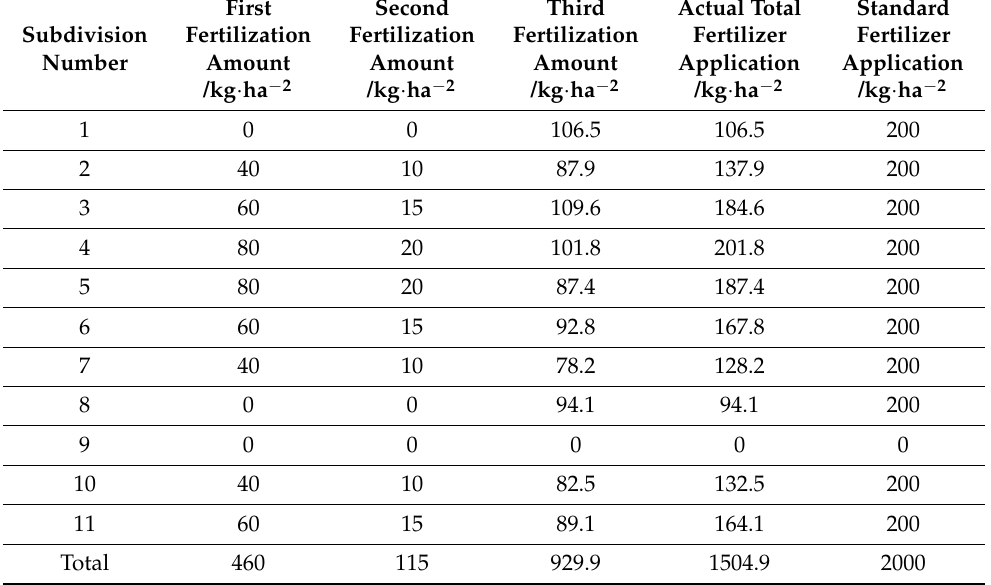
Table 2. Actual fertilizer chasing in each